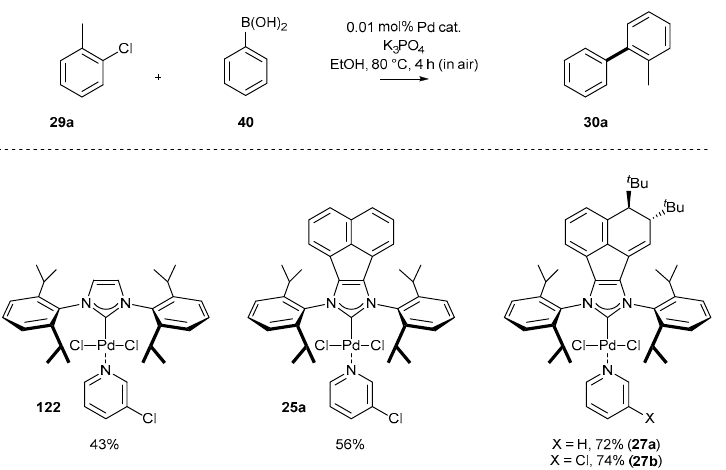
Scheme 52. Influence of backbone modification of NHC ligands on catalytic activity in the Suzuki coupling.